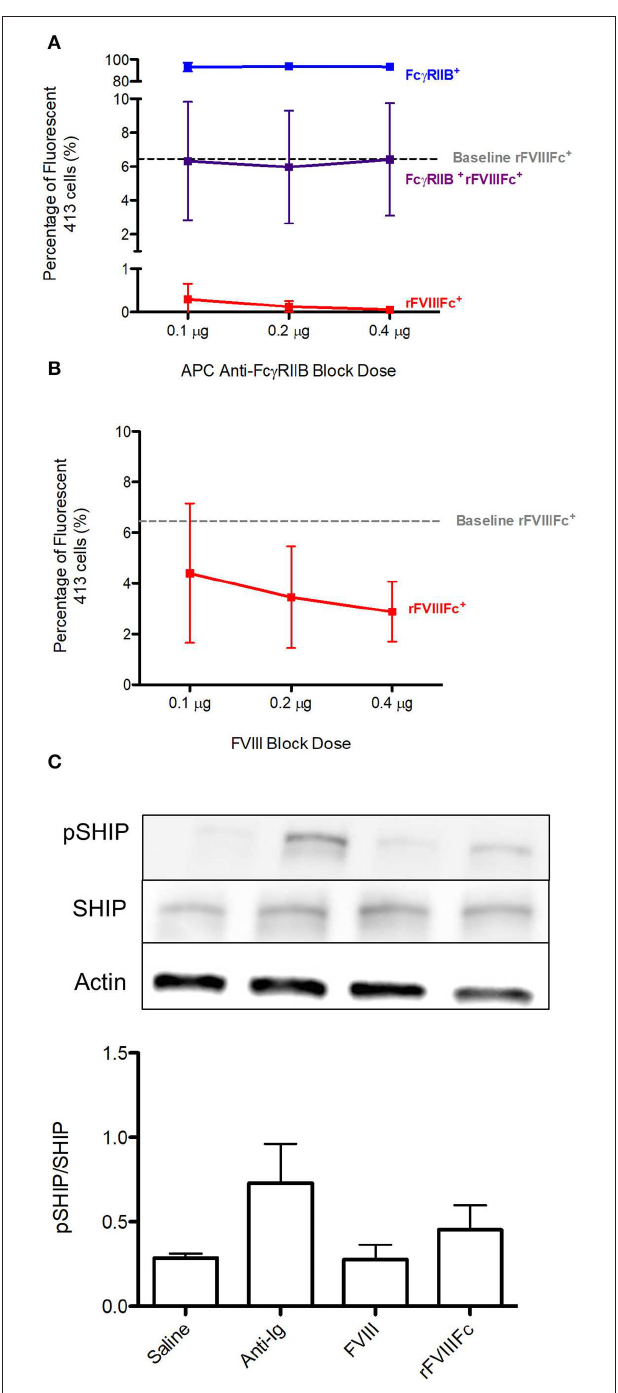
FIGURE 7 | rFVIIIFc binds 413 cells via Fc γ RIIB as well as the BCR and results in increased SHIP phosphorylation. The percentage of rFVIIIFc + 413 cells when blocking with (A) APC anti-Fc γ RIIB (0.1, 0.2, or 0.4 µ g) or (B) FVIII (0.1, 0.2, or 0.4 µ g) prior to YFP rFVIIIFc (0.3 µ g) incubation. Baseline rFVIIIFc corresponds to the percentage of rFVIIIFc + cells in the absence of APC anti-Fc γ RIIB or FVIII. (C) pSHIP levels in saline, anti-Ig (20 µ g/ml), FVIII (11.4 µ g/ml) and rFVIIIFc (14.7 µ g/ml) stimulated 413 cells. Ratios of phosphorylated SHIP to total SHIP were obtained through densitometry analysis of three different blots. n = 3/condition. Error bars represent